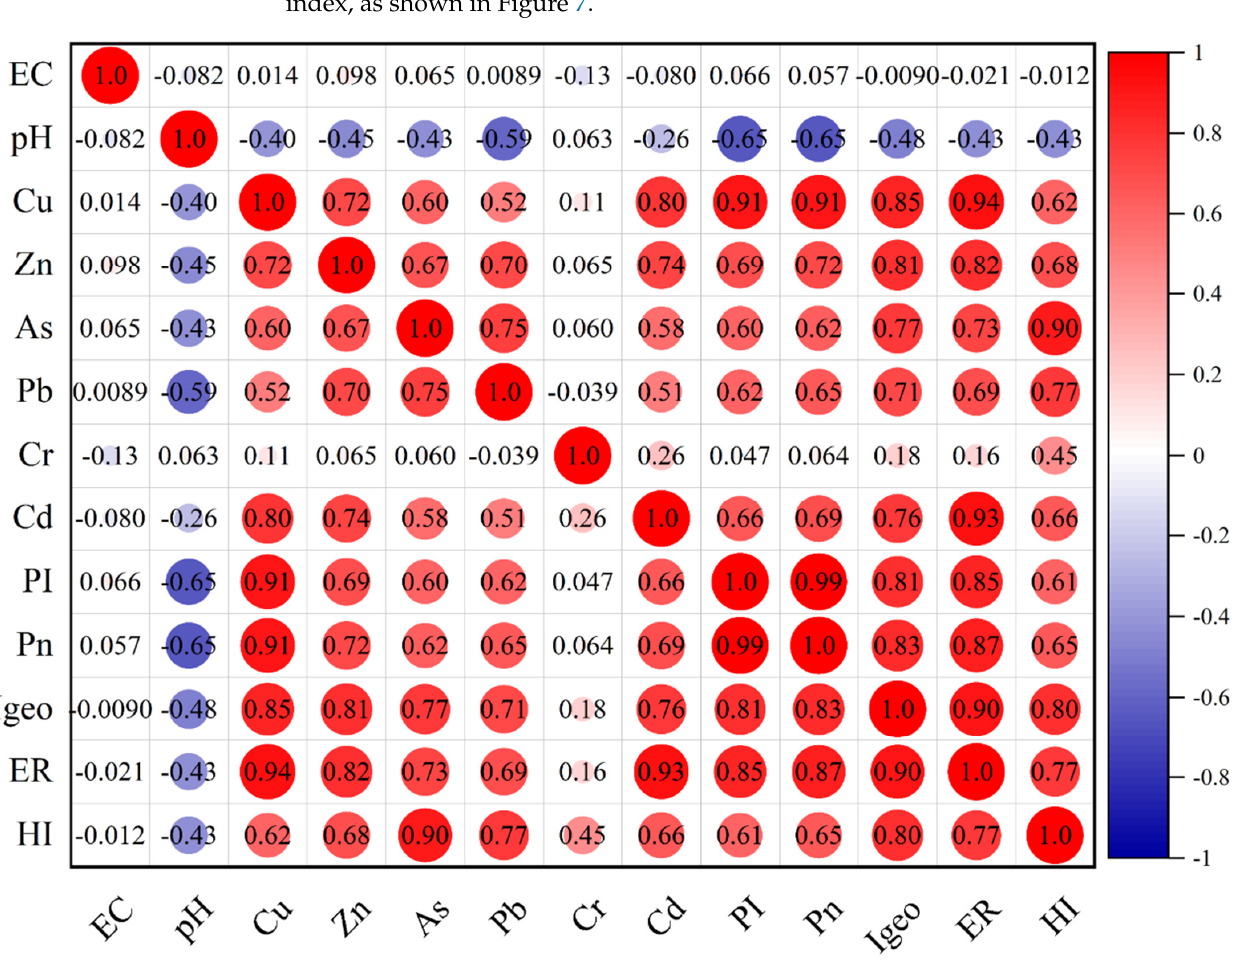
Figure 6. Results of correlation analysis of metal concentrations, soil parameters and evaluation indices. X: Parameters of correlation analysis; Y(left): Parameters of correlation analysis; Y(right): correlation coefficient.